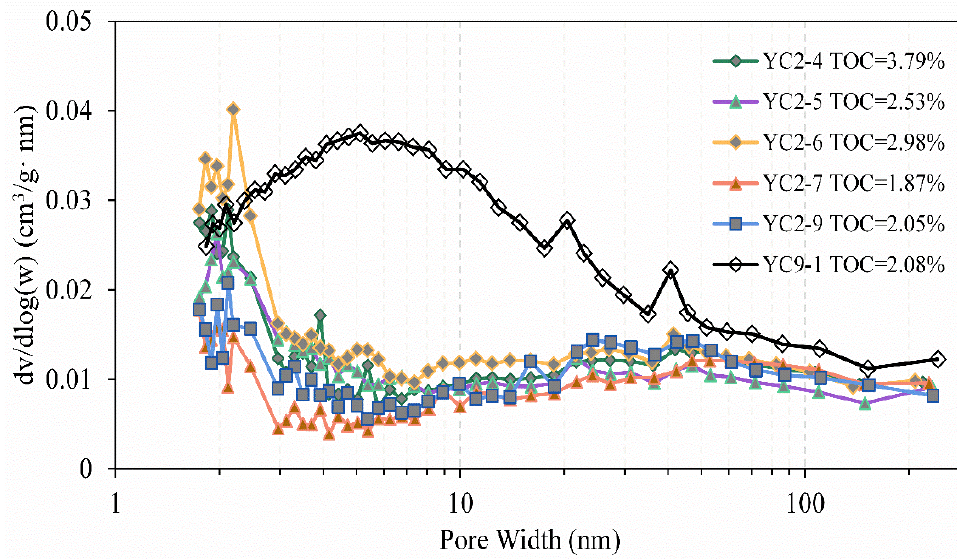
Figure 9. PSD curves of the selected samples with different TOC based on their LPNA data. The peak range is between 1.7 nm and 3 nm for the YC2 samples, while sample YC9-1 has a gentle bulge in a range of 1.7–50 nm, without an obvious peak.